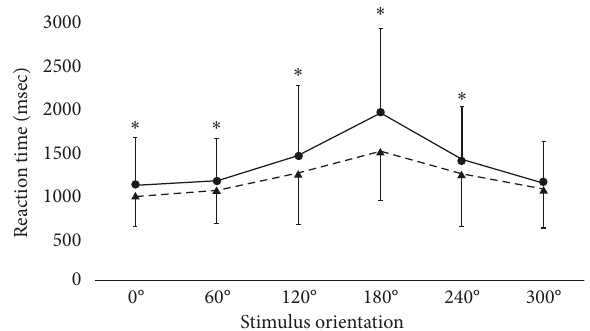
Figure 3: Mean reaction times of three stimulus types of TMD group (circles) and control group (triangle). Error bars indicate standard deviations. Asterisks indicate significant differences be- tween two groups ( p < 0 . 05).